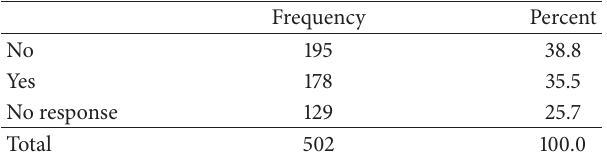
Table 6: Malaria occurrence after spraying and using